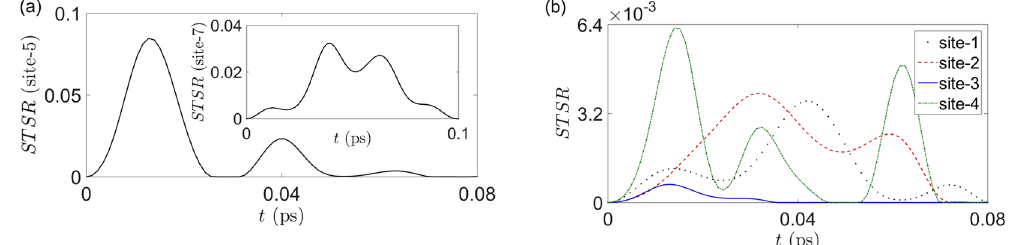
Figure 4. Evolution of the STS robustness ( ST SR ) in the FMO complex. ( a ) The main figure together with the ST insets show the decays of the STS robustness of the assemblages σ t { ( )} of site-5 and site-7 respectively. ( b ) a x a x , The black-dotted, red-dashed, blue-solid, and green dash-dotted curves are represent STS robustness of the ST assemblages σ t { ( )} of site-1, 2, 3, and 4 respectively. As the previous case, the measurement settings on site-6 a x a x , at time 0 are the Pauli set X , Y , and Z . We assumed that the FMO is cooled down to T = 15 K, the FMO initial state is completely mixed at site-6 while the other sites are in ground state, the dephasing rate is 7.7 cm − 1 , and the decay rate is 5.3 cm − 1 . Again, for brevity, we do not present analogous plots for the STS